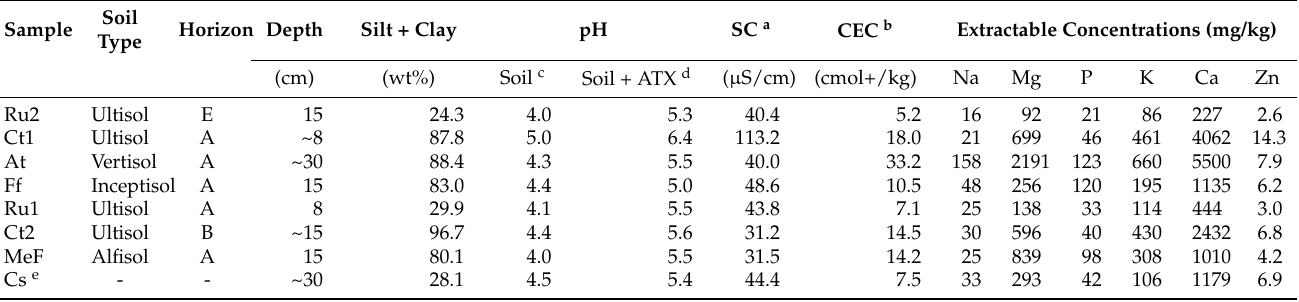
Table 1. Sample physical and extractable chemical characteristics (SC, specific conductance; CEC, cation exchange